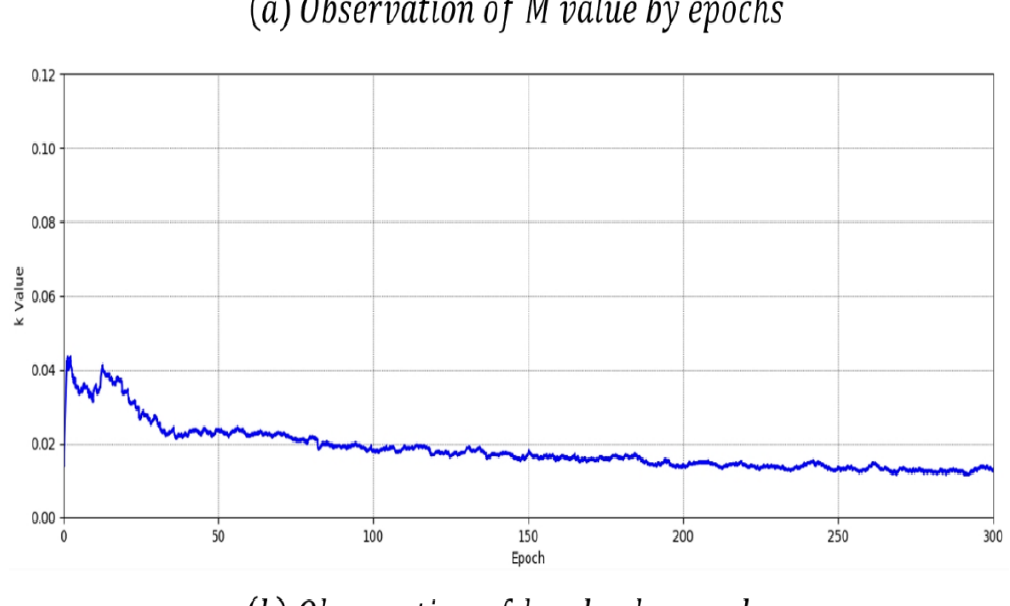
Figure 18. Convergence measurement results of the proposed model using L1 loss.